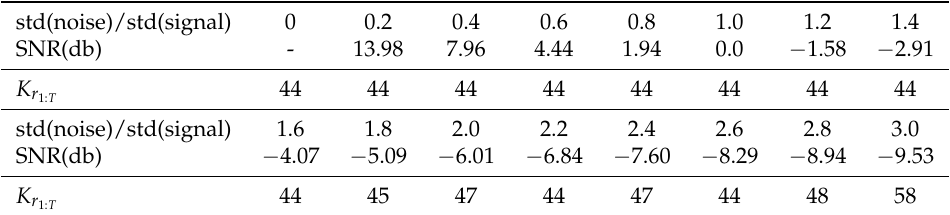
Table 1. The number of change points with respect to noise level (True K =